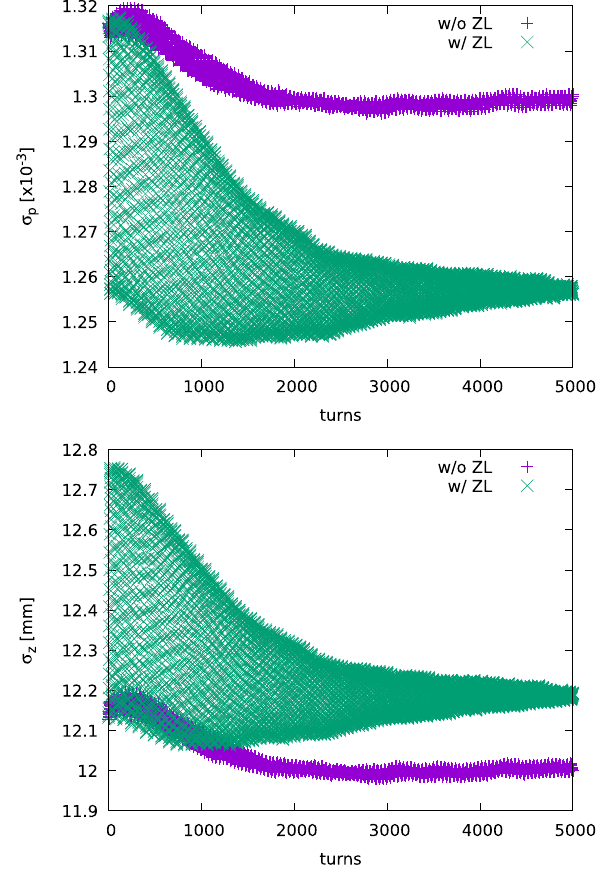
FIG. 2. The energy spread (top) and the bunch length (bottom) versus number of revolution turns with (green traces) and without (viola curves) beam coupling impedance at the 45.6 GeV